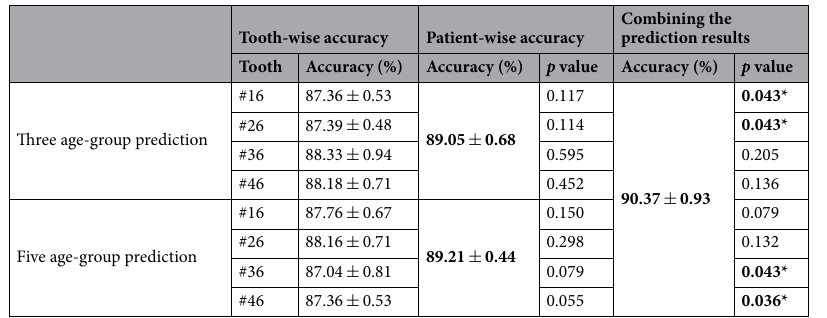
Table 1. Age-group estimation accuracy of tooth-wise and patient wise predictions. The results were obtained using unequal variance t-tests. A two-tailed p value < 0.05 was considered statistically significant. * p value < 0.05. Significant variables and results shown in bold